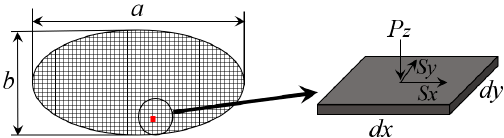
Figure 11. Forces on elements of contact patch.